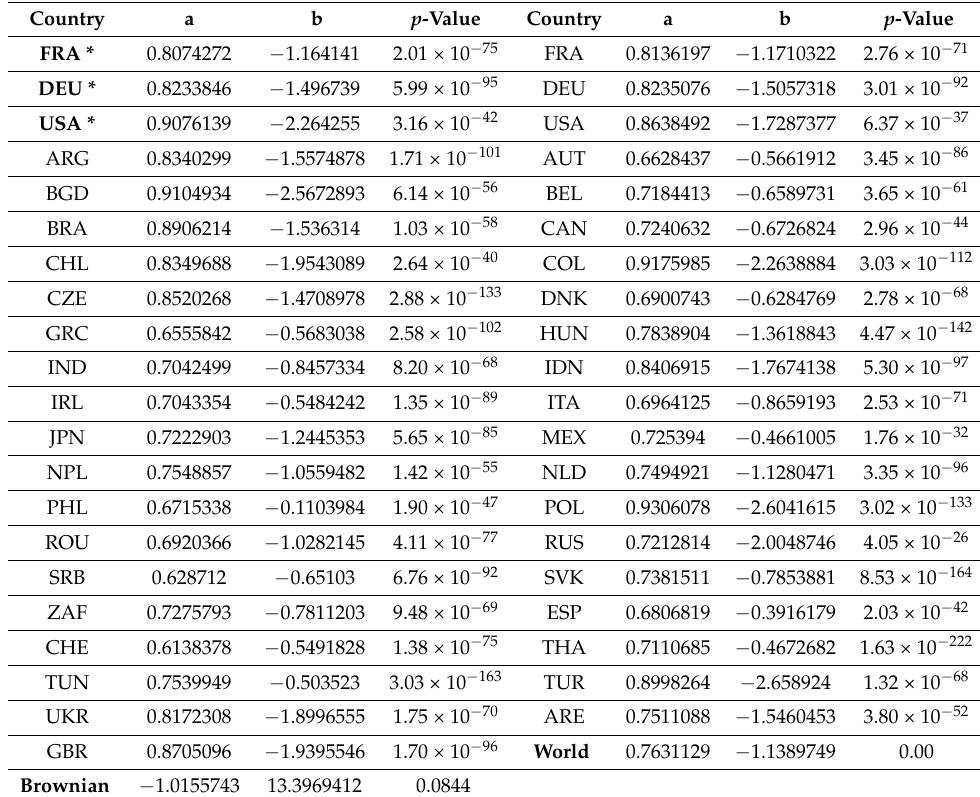
Table A2. Coefficients a and b for 38 countries of the log-log linear regression ax + b between restored | as displayed in Figure 5. The Pearson correlation p -values given incidence i r and the residual | ˆ i t − i r t t by the stats R package confirm a linear relation. The exponent a varies between 0.7 and 0.9. Stars * indicate countries with festive correction. The pvalues are slightly better with festive correction than without. The last row shows the results on the control curve, simulated as a Brownian process. Its large p -value discards a linear log-log relation, and the estimated values of a and b also stand far away from the estimated values for real incidence